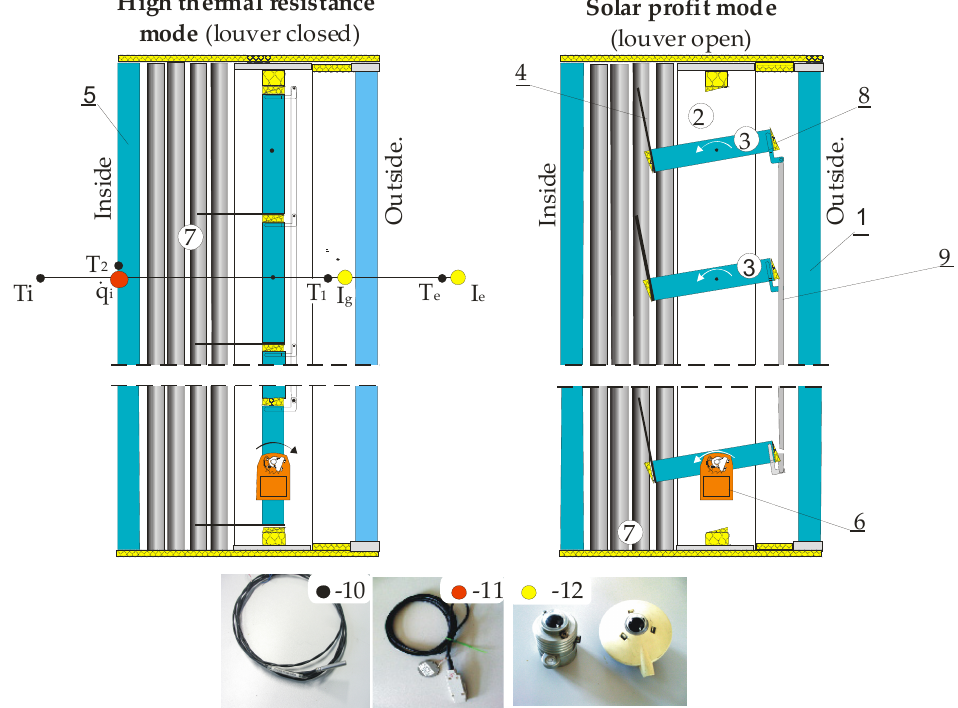
Figure 4. The prototype of the tested wall: 1—exterior glazing, 2—louvers headrail, 3—swivelling louvers panels, 4—moveable absorber, 5—interior glazing, 6—louvers panels swivelling actuator, 7—